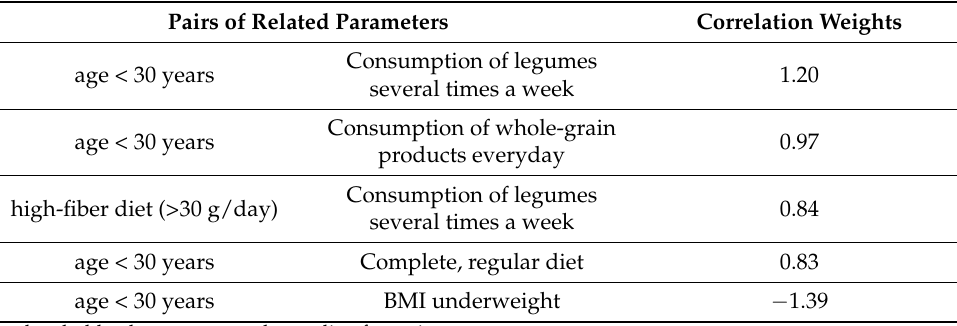
Table 3. Association weights for age or fiber diet categories and consumptions of various plant prod- ucts, regular diet, or BMI category, based on the correspondence analysis model (BMI underweight— BMI < 18.5 kg/m 2 ).